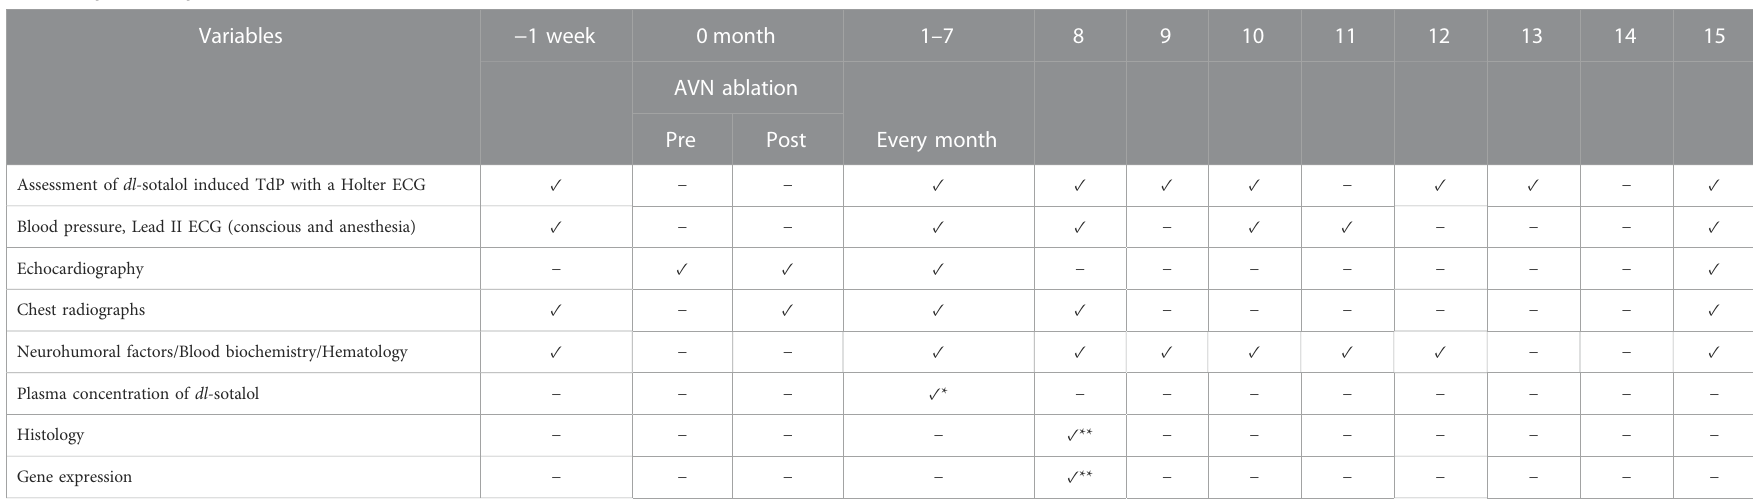
TABLE 1 Experimental protocol.